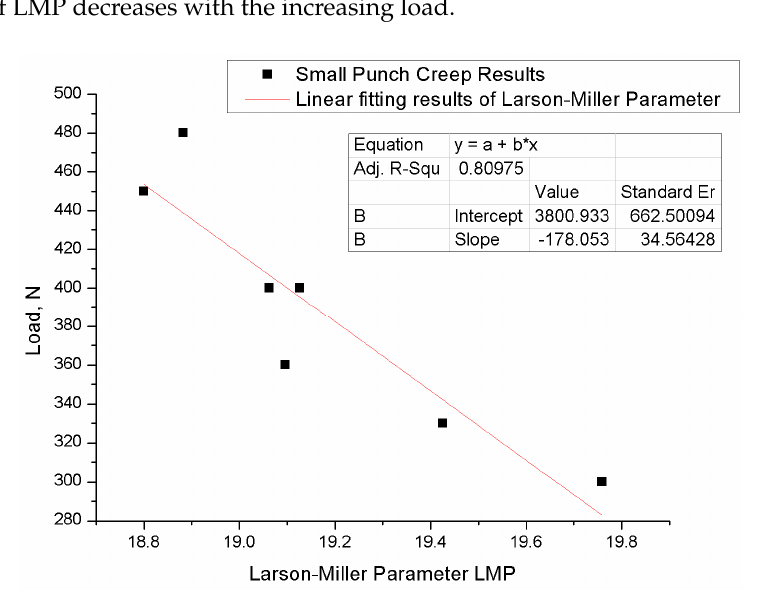
Figure 10. The Larson-Miller fitting result of the small punch creep test of 16Mo3.